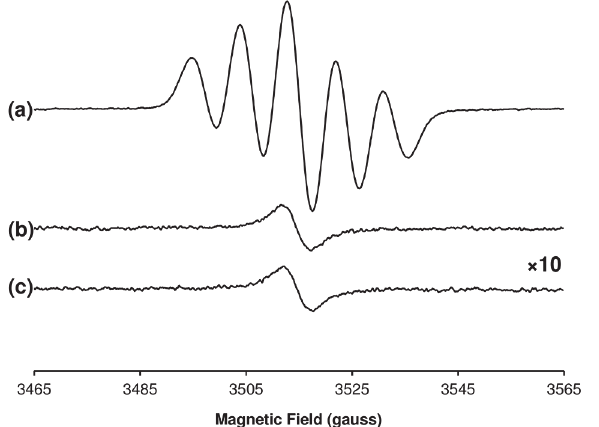
Fig 6. Antiradical activity of brewed coffee does not consume or generate stable coffee radicals. Room-temperature CW-EPR spectra of 1:1 MeOH/water solutions containing (a) 50 μ M DPPH (cid:129) alone, (b) brewed coffee added to an equal volume of 100 μ M DPPH (cid:129) in MeOH, and (c) brewed coffee added to an equal volume of MeOH. Data represent results of assay performed on a single brew. For clarity, the vertical scale is an order of magnitude higher spectra in b and c as compared with a . Experimental conditions: microwave frequency, 9.860 GHz; microwave power, 10 mW; magnetic field modulation amplitude, 4 G; field modulation frequency, 100 kHz; receiver time constant, 82 ms; receiver gain, 70 dB; sweep rate, 4 G/s; averages, ( a ) 4, ( b , c ) 40.